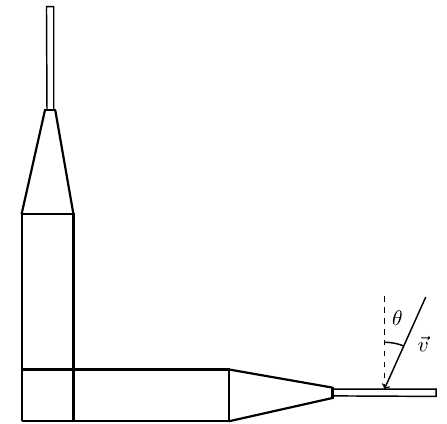
Figure 1. Wind sensor design. The hot films were mounted at the end of two separate holders, which were set perpendicular to each other (Davey et al.,